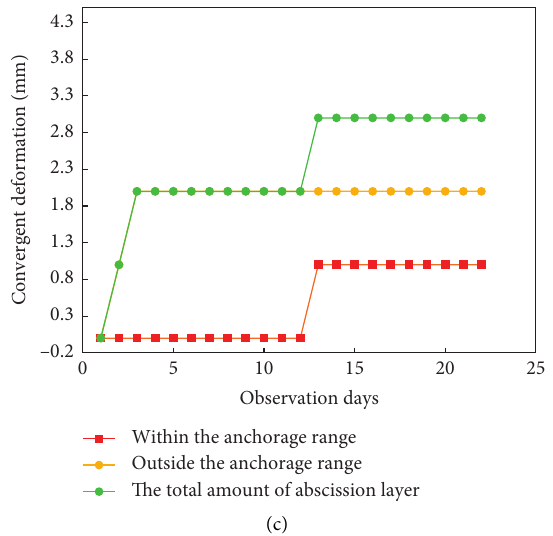
Figure 13: Roof separation of the station. (a) #1 measurement station. (b) #2 measurement station. (c) #3 measurement